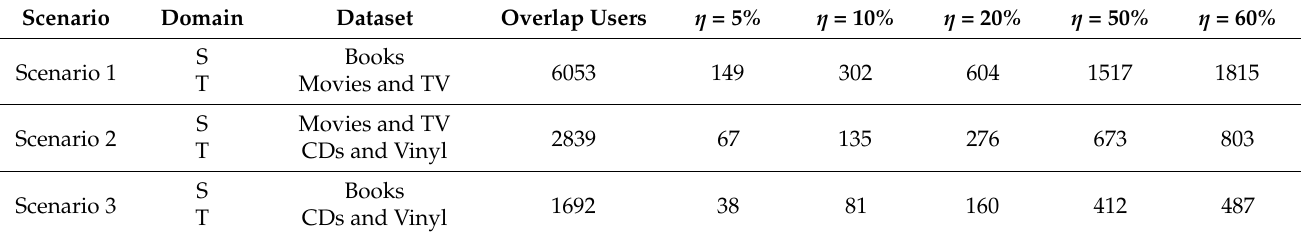
Table 1. Statistics of the Amazon